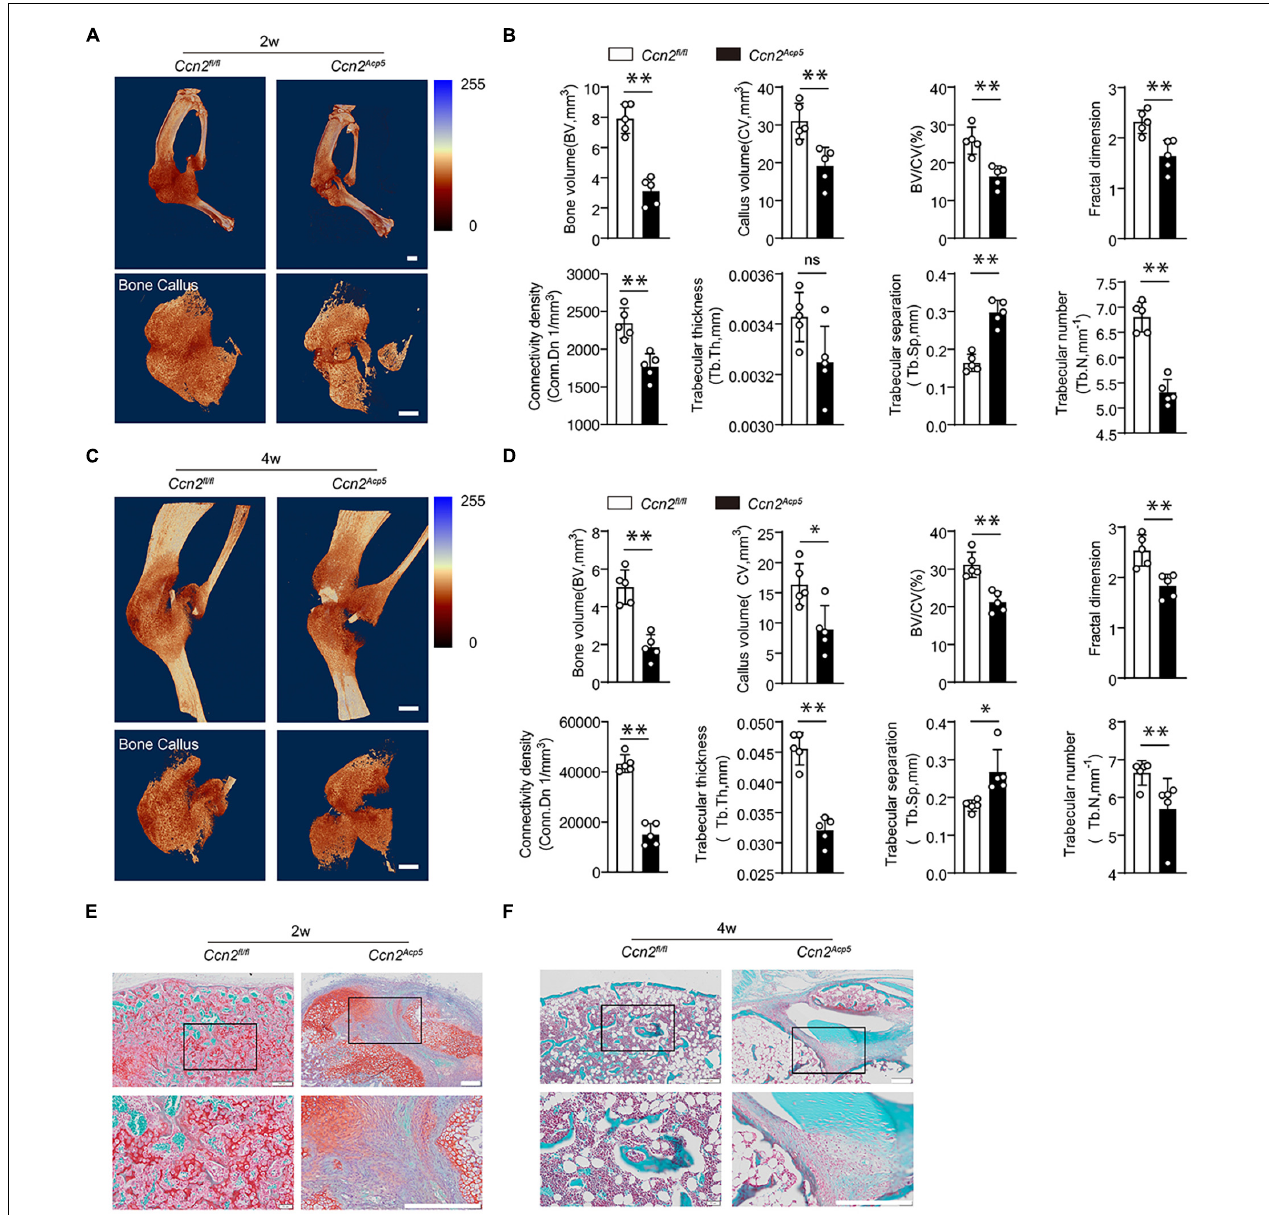
FIGURE 3 | CTGF from preosteoclasts induces callus formation during bone healing. CTGF floxed mice ( Ccn2 fl / fl mice) were crossed with Acp5-Cre mice to generate TRAP lineage-specific Ccn2 deletion mice ( Acp5-Cre; Ccn2 fl / fl , short as Ccn2 Acp 5 ). The tibial fractures were induced on 8-week-old Ccn2 Acp 5 mice and Ccn2 fl / fl mice. (A) Representative 3D micro-computer tomography ( µ CT) images of tibia bone callus 14 days post fractures in Ccn2 fl / fl and Ccn2 Acp 5 mice. Scale bars, 2 mm. (B) Quantitative µ CT analysis of (A) . (C) Representative 3D micro-computer tomography ( µ CT) images of tibia bone callus 28 days post fractures in Ccn2 fl / fl and Ccn2 Acp 5 mice. Scale bars, 2 mm. (D) Quantitative µ CT analysis of (C) . The µ CT parameters includes CV (callus volume), BV (bone volume), BV/CV, FD (Fractal dimension), Tb.Th (trabecular thickness), Tb.Sp (trabecular separation), Tb.N (trabecular number), and Conn.Dn (Connectivity density). (E) Representative images of tibia callus Safranin O/Fast green staining on 14 days post fractures in Ccn2 fl / fl and Ccn2 Acp 5 mice. Scale bars, 200 µ m. (F) Representative images of tibia callus Safranin O/Fast green staining on 28 days post fractures in Ccn2 fl / fl and Ccn2 Acp 5 mice. Scale bars, 200 µ m. Data are expressed as mean ± SD. ∗ P < 0.05, ∗∗ P < 0.01.